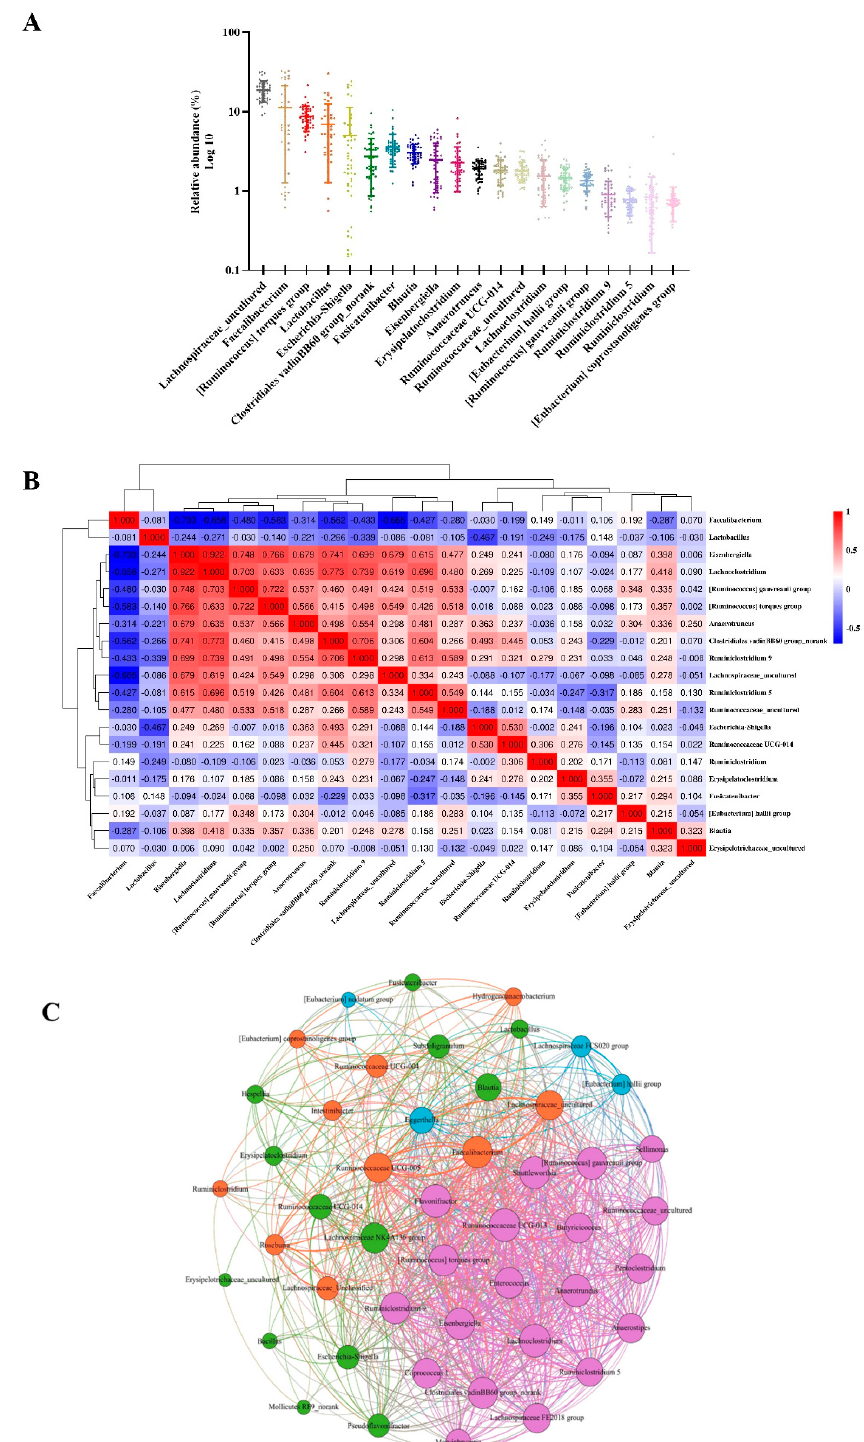
Figure 6. The core intestinal microbiota composed of 20 bacterial genera in broilers. ( A ) The abundance distribution of the 20 core genera. ( B ) Correlation matrix showing the Spearman’s rank correlations among the collective core, which range from − 1 to 1, corresponding to a strongly positive to a strongly negative correlation, respectively. ( C ) According to the co-occurrence network, the sold line indicated that Spearman’s rank correlation coefficient was >0.5 with a p -value < 0.05. The size of the node was related to the abundance of the genus. Colours of nodes and lines corresponded to phylum to which the genus